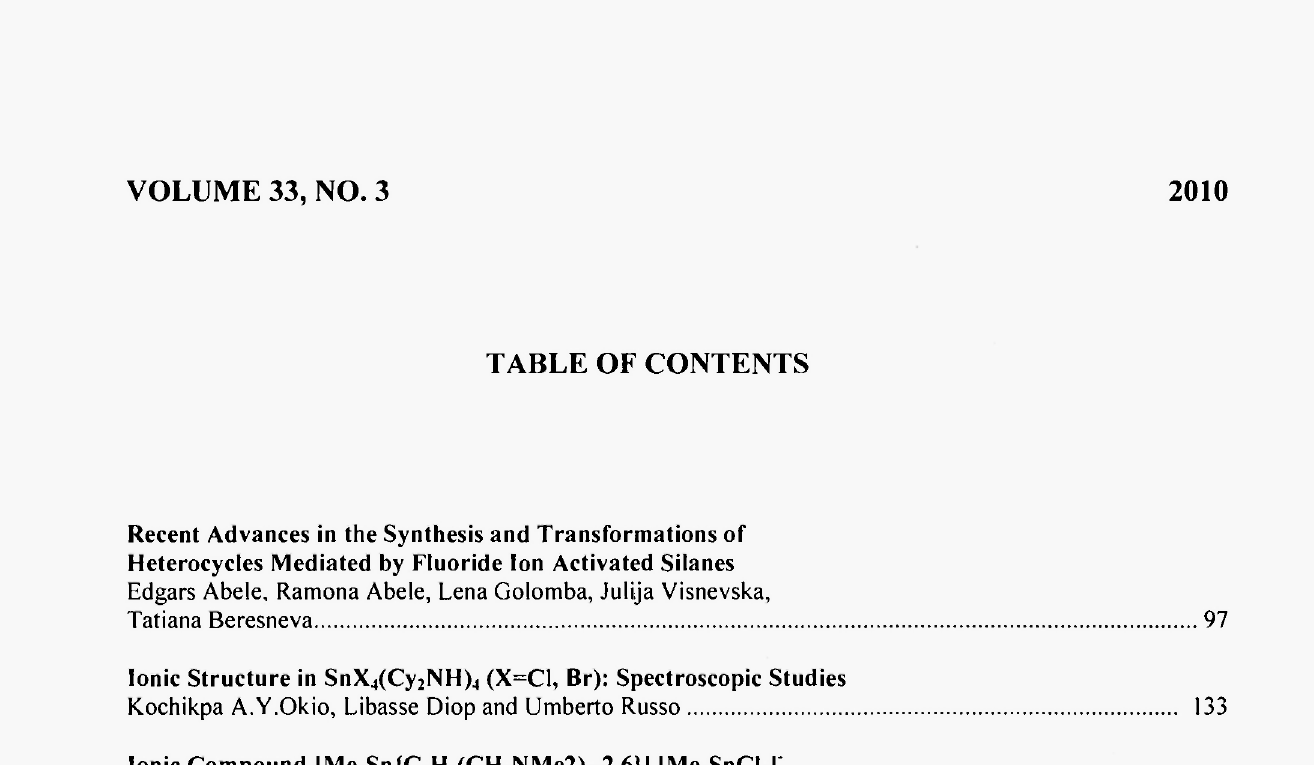
Microwave Assisted Synthesis, Spectroscopic Characterizations In Vitro Antibacterial and Antifungal Properties of Some Antimony And Bismuth Complexes Derived from Ν S Donor